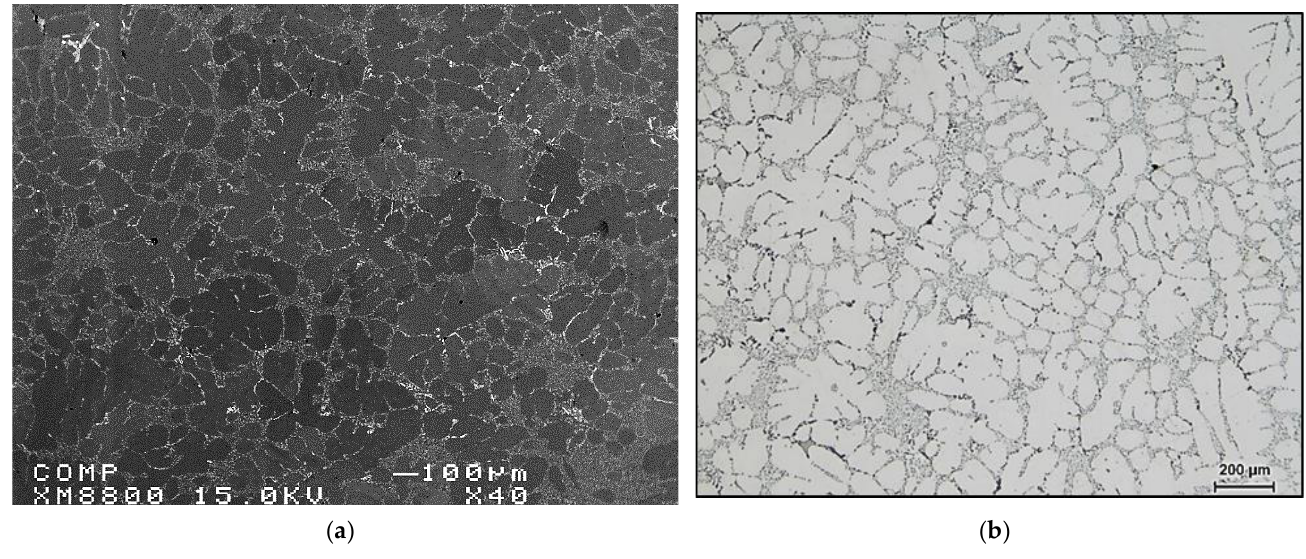
Figure 10. ( a ) Backscattered electron micrograph and ( b ) optical micrograph of a sample obtained from a well-degassed melt.